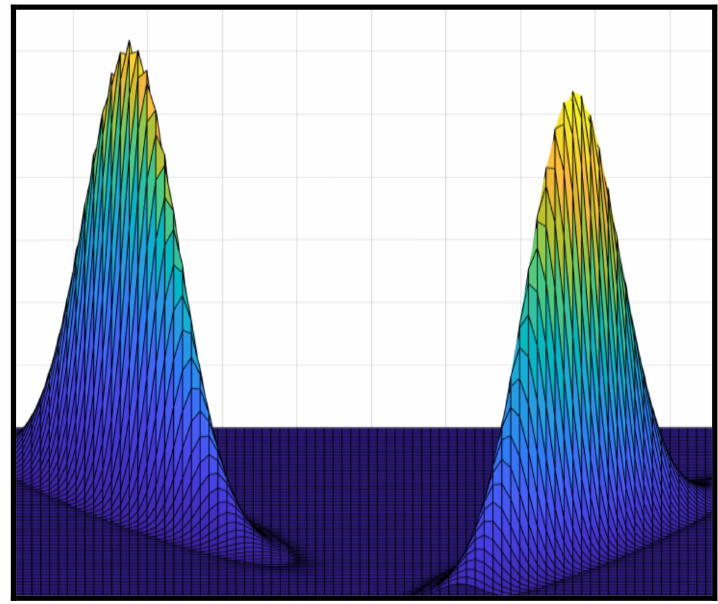
Figure 1. Two uncertain datasets, each expressed by a PDF. Cluster validity indices (CVIs), which are indicators for validating the quality of clustering algorithms, have been widely used to determine the correct number of clusters for the given data. As the CVIs only use input data information, they must be used according to the characteristics of the data. The two components of a CVI are compactness and separability measures. The former refers to an intra-cluster distance, and the latter represents an inter-cluster distance. Most CVIs indicate that a good partition produces a small compactness value and a high separability value. However, the existing CVIs are vulnerable to validating cluster results when the shapes of the clusters are not spherical clusters